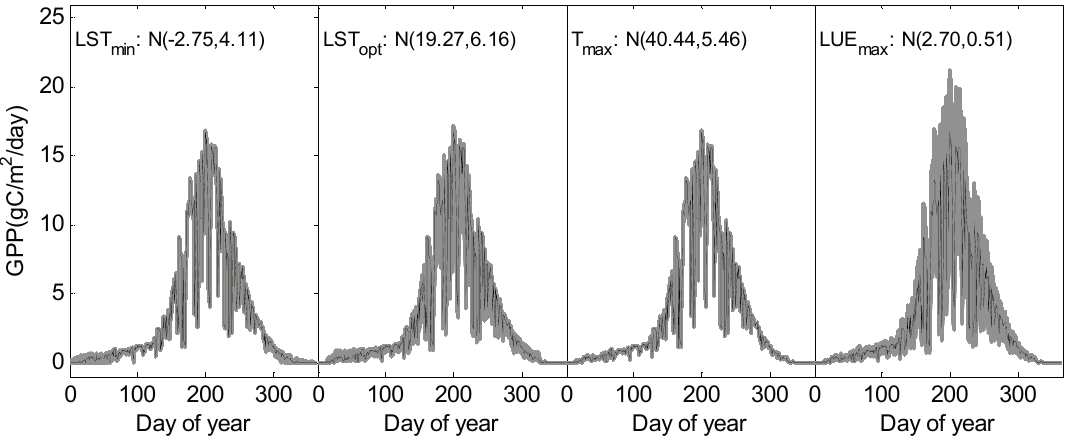
Figure 9. Uncertainties in the GPP caused by parameters in the RS-CFLUX model. N (mu, delta) is a normal distribution with a mean mu and standard deviation